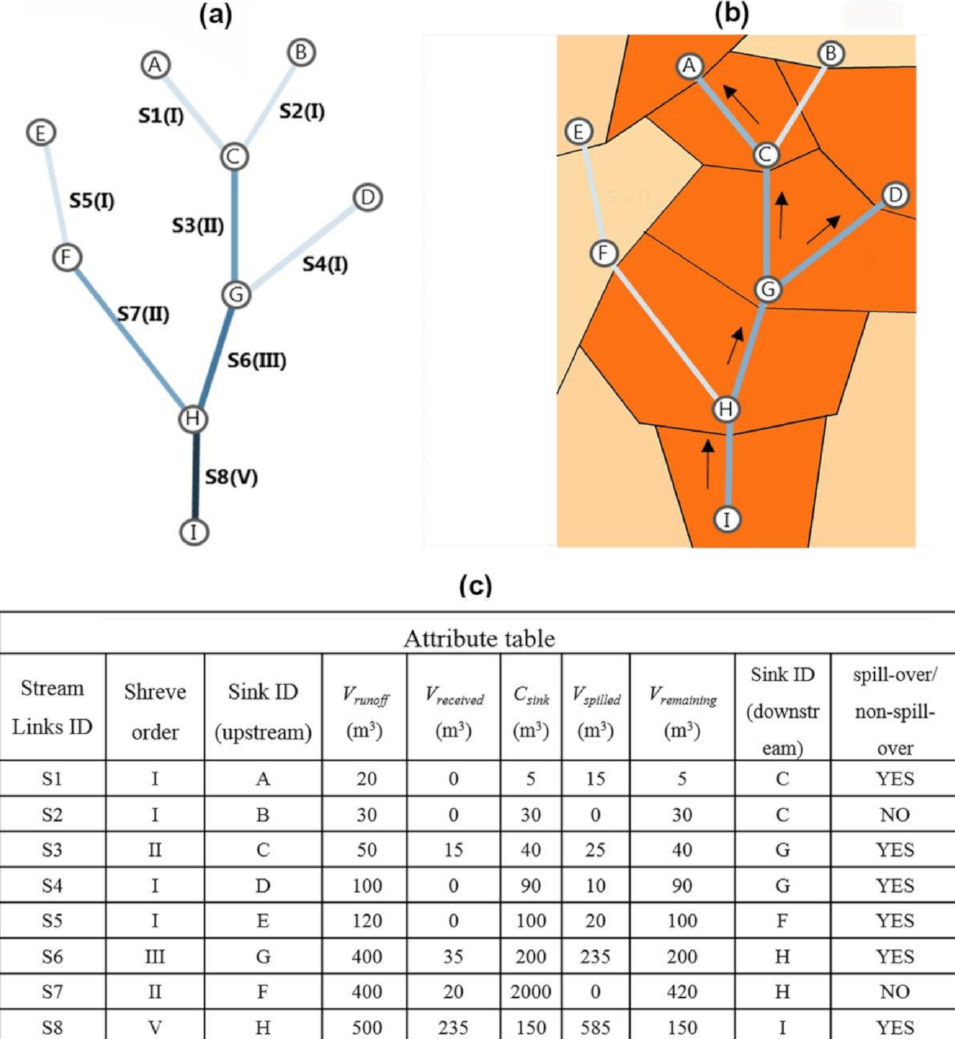
Figure 3. ( a ) The geometric features of the stream link feature class, where points represent sinks with IDs (A–I), and edges representing their assigned stream links (S1–S8); the gradually darker blue colour symbolized the increase in Shreve stream order (I–V), which determines the computing sequence of stream links. ( b ) The targets-based upstream tracing operation, illustrated for target sink I. Black arrows represent tracing directions when searching for connected upstream stream links and the number of stream link features involved (S8–S6–S3–S1 and S8–S6–S4) intuitively reflecting optimal tracing distances. Dark orange areas symbolized identified sub-impact zones to be included while light orange areas symbolized eliminated sub-impact zones identified as irrelevant to the target objects (Sink I). ( c ) The stream link feature class’ attribute table where the computational information is constructed by joining two points onto one stream link based on their spatial intersection (i.e., points A and C are the endpoints of edge